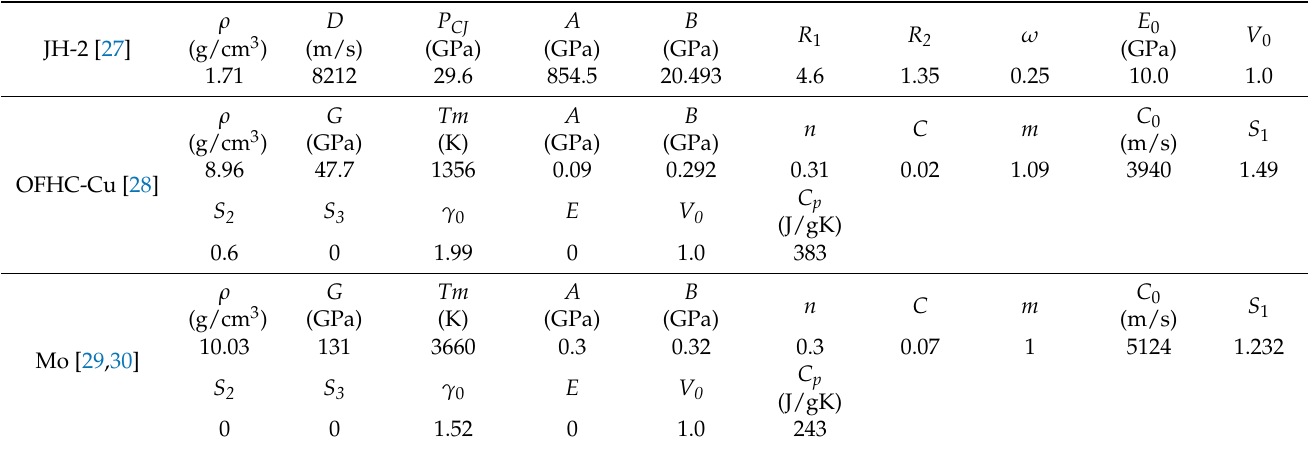
Table 2. Comparison of jet morphology.